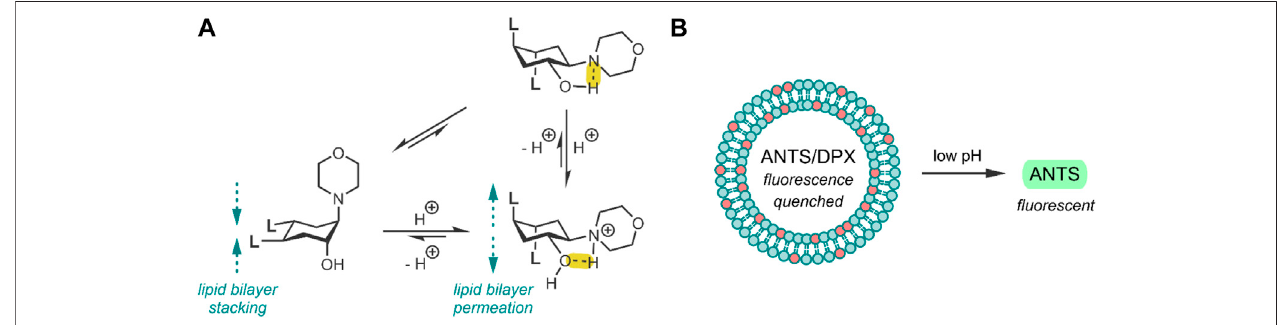
FIGURE 1 | (A) pH-induced conformational change of the TACH-lipid derivative, where L is the lipid tail -COOC 12 H 25 . Hydrogen bonds have been highlighted in yellow. (B) 25 mol%TACH-lipid derivative (red) and75 mol%POPC (blue)liposome formulationcontainingtheANTS/DPXdye/quencherpair. Acidic conditions resultin liposomal leakage and the dequenching of ANTS (Brazdova et al.,